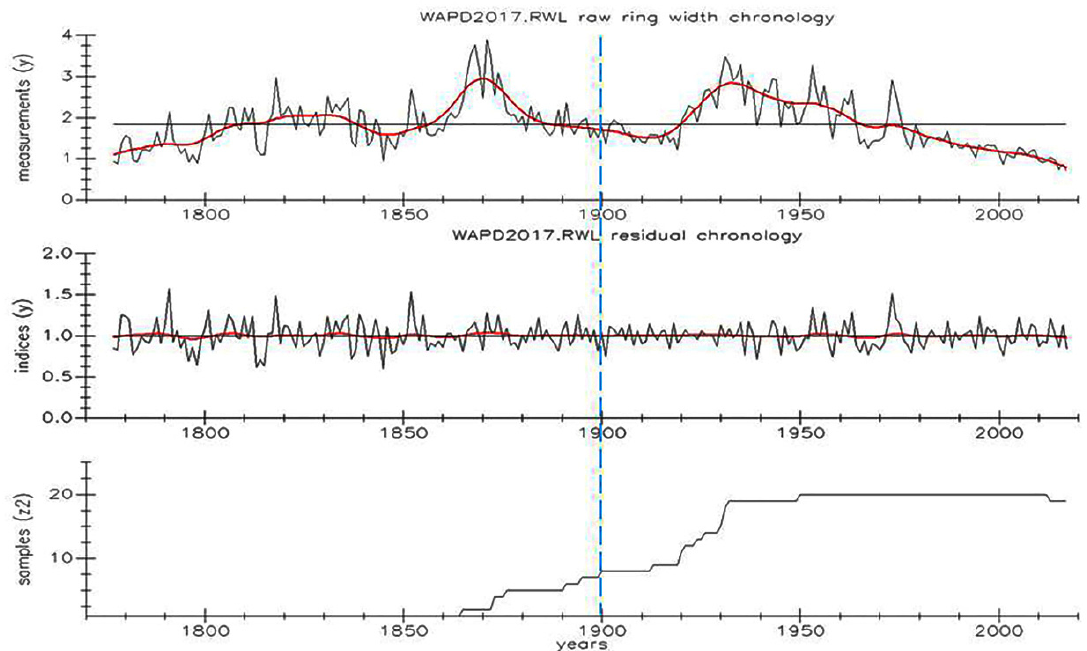
Figure 4. The chronology and sample depth of P. densiflora from Mt. Worak (dotted line is SSS ≥ 0.85).